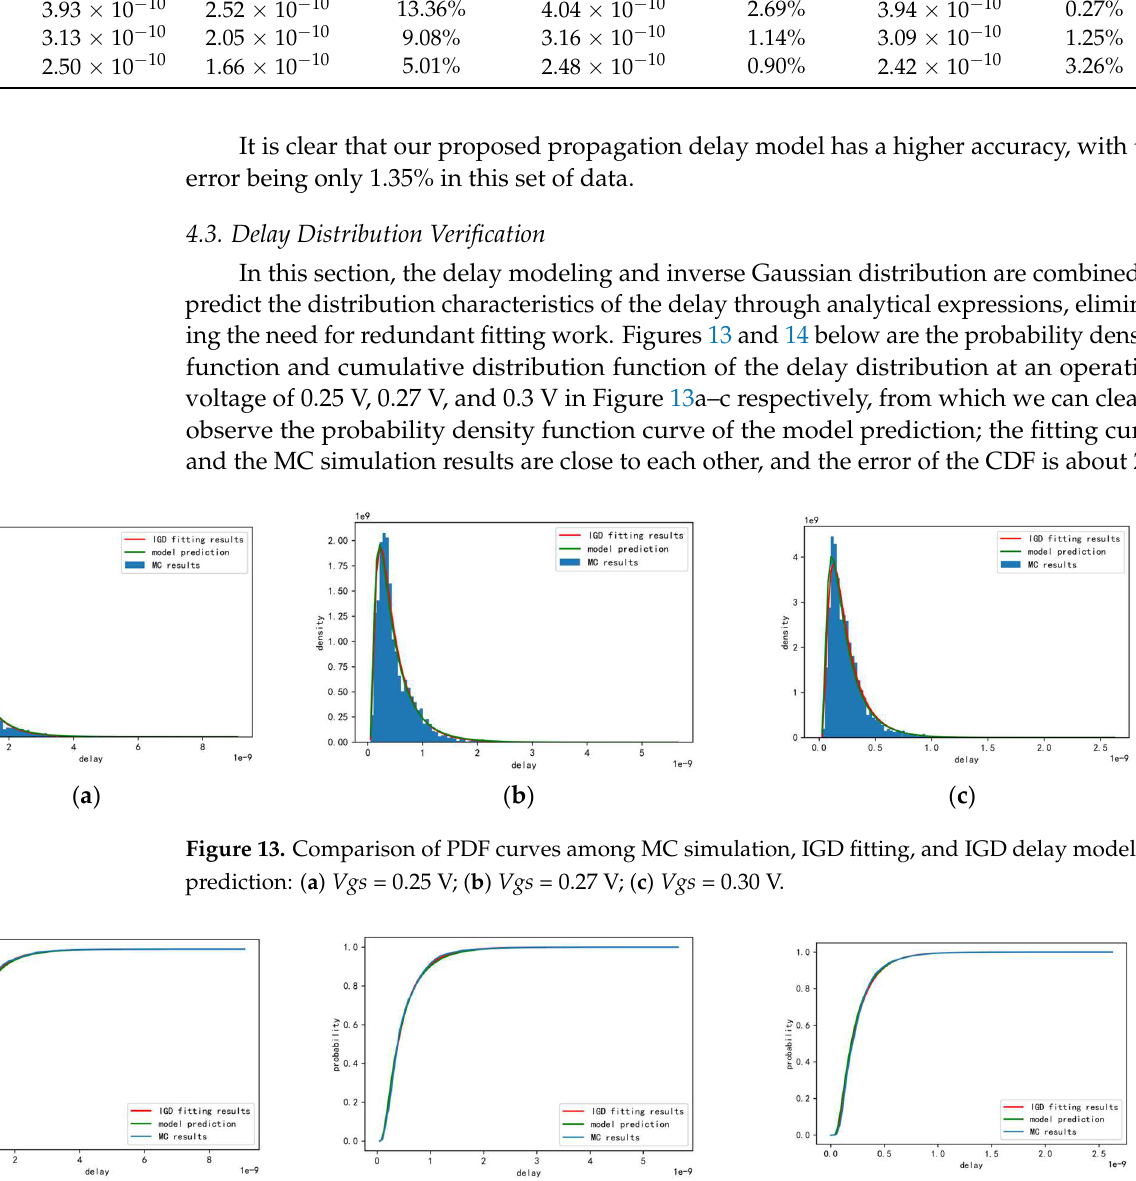
Table 18. Propagation delay at different voltages (T = 25 °C, Cl = 0.5 fF, τ = 1 × 10 −11 s, Vbs = 0).